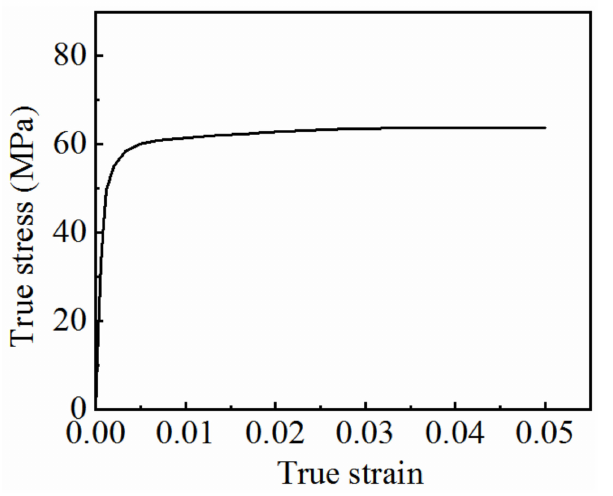
Figure 6. True stress–strain curve of 7075 aluminum alloy at 350 ◦ C and strain rate of 0.01 s − 1 obtained by uniform deformation calculation